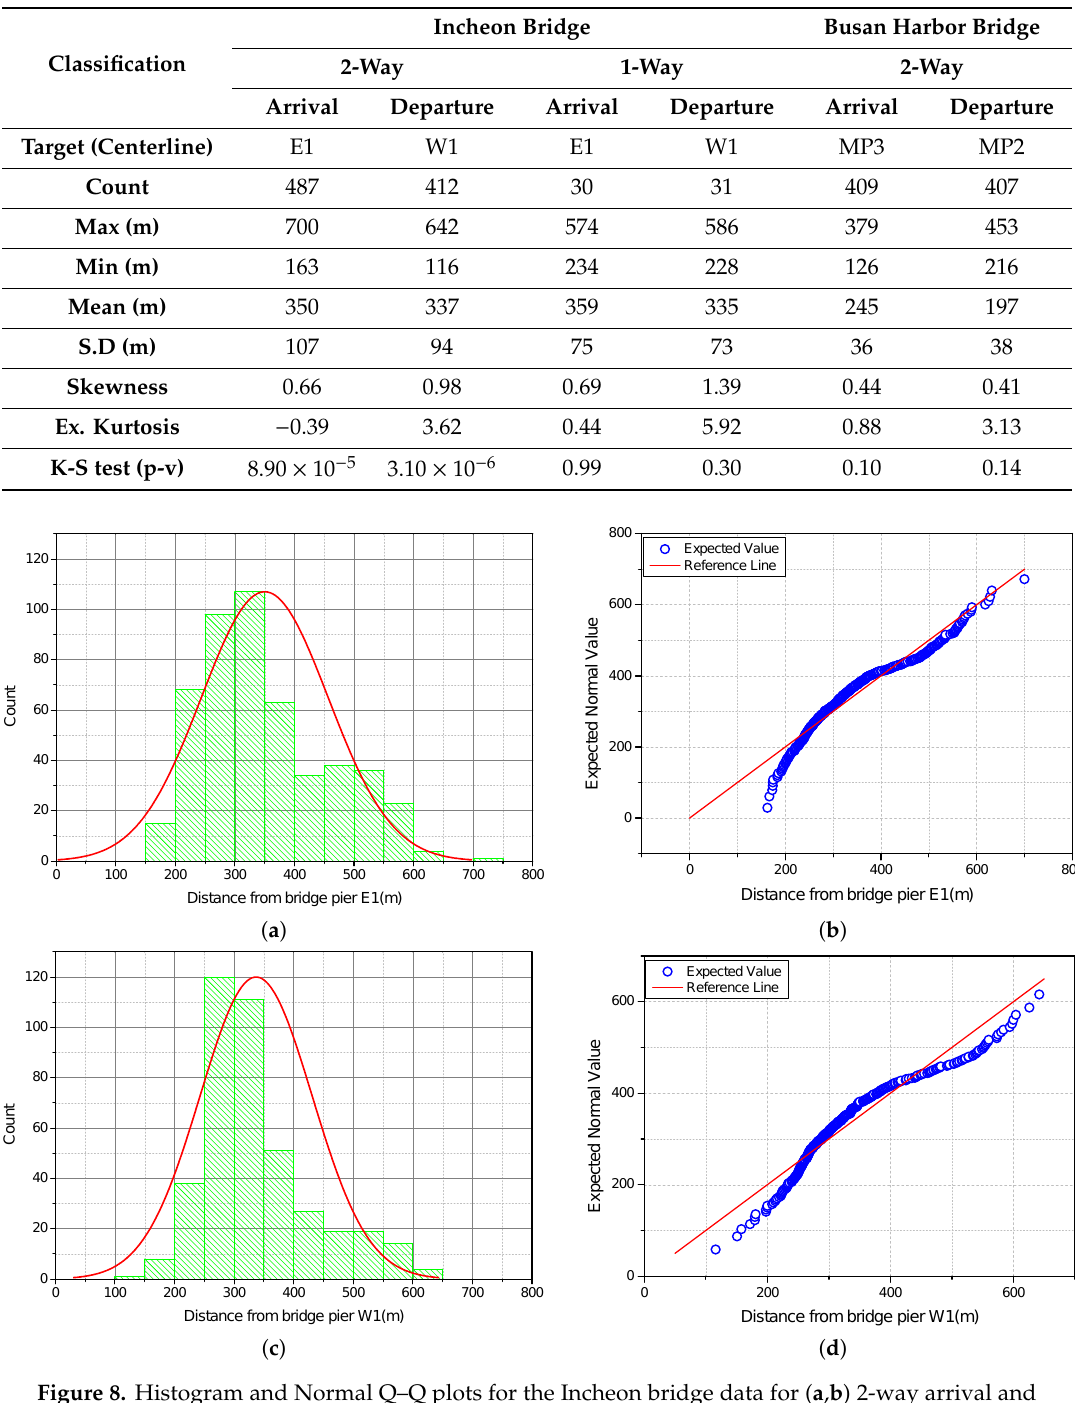
Table 9. Summarized data for normality tests of tra ffi c distributions.